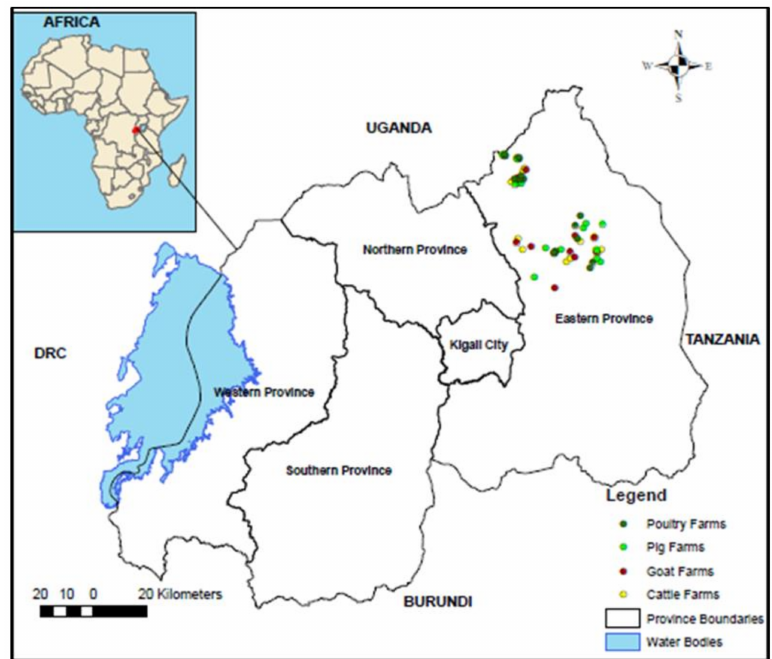
Figure 1. Location of visited farms in the East province of Rwanda. Approximate locations of visited farms were generated based on administrative units (cells) where farms were